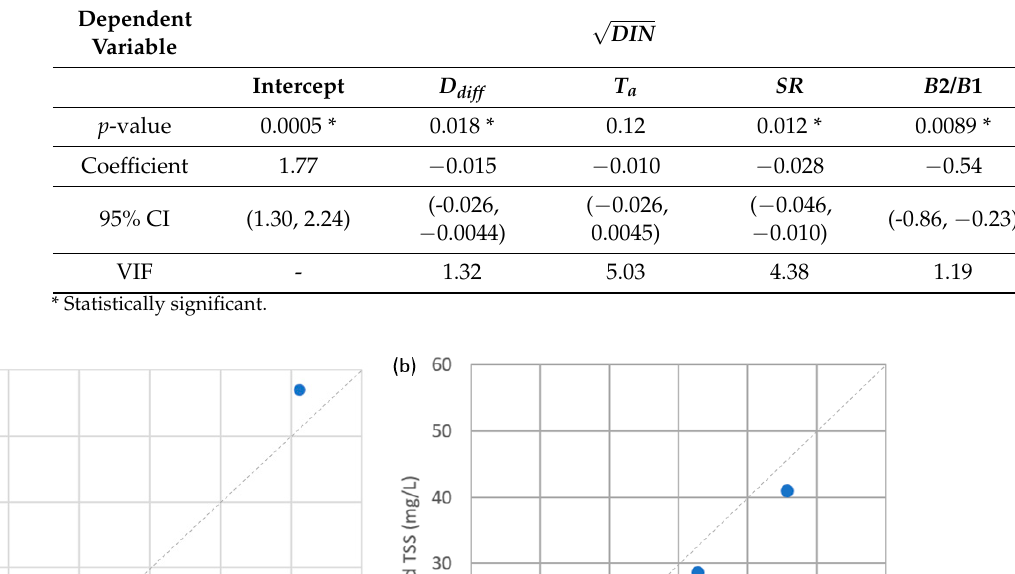
Table 6. Statistical model to predict DIN concentration from remotely sensed data.